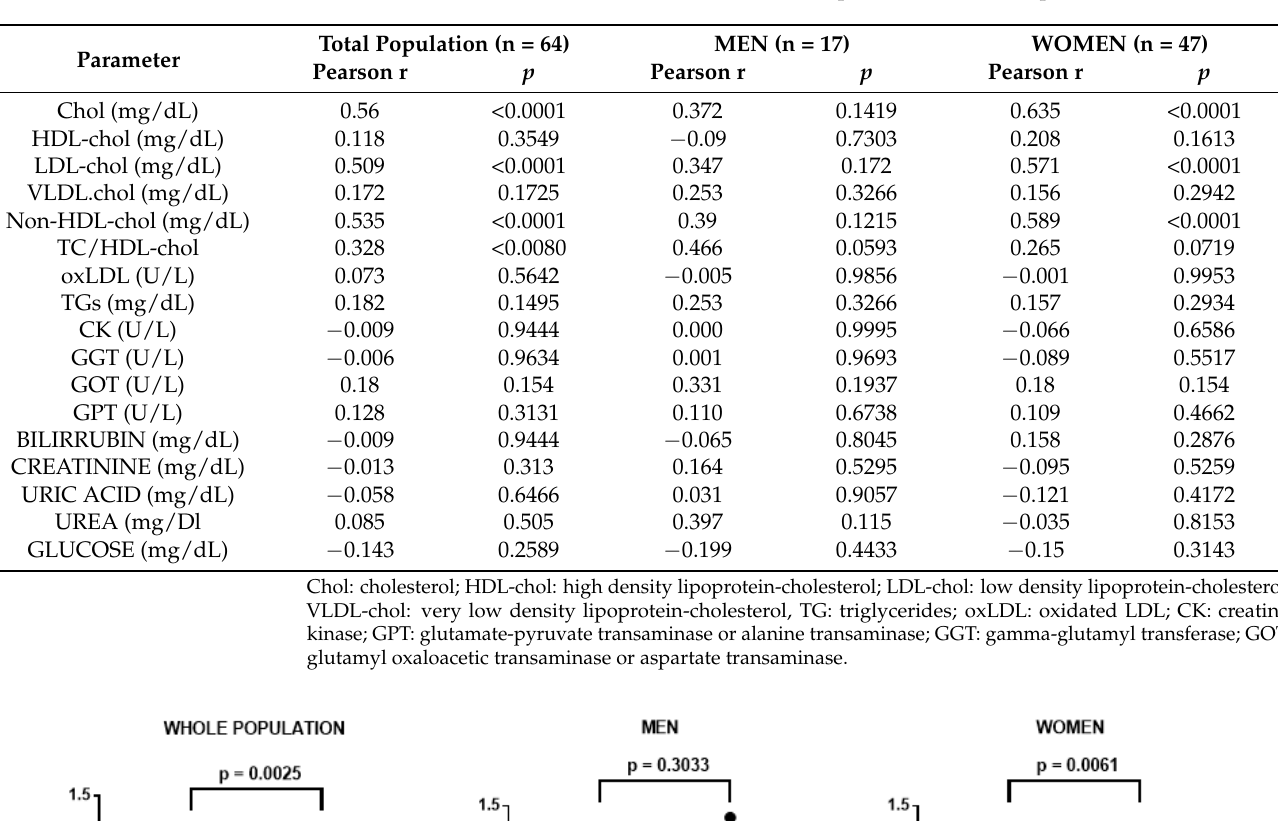
Table 4. Correlation between CoQ 10 levels and blood plasma biochemical parameters.